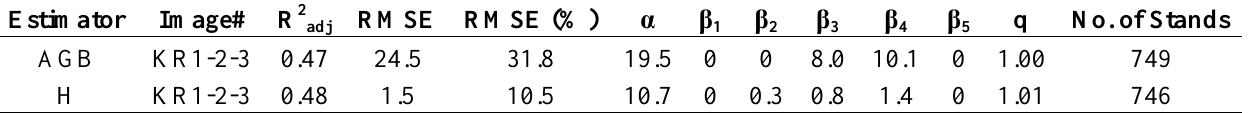
Table 6. Regression model parameters for AGB (tons∙ha −1 ) and H (m) described for Equation (5) at Krycklan at stand